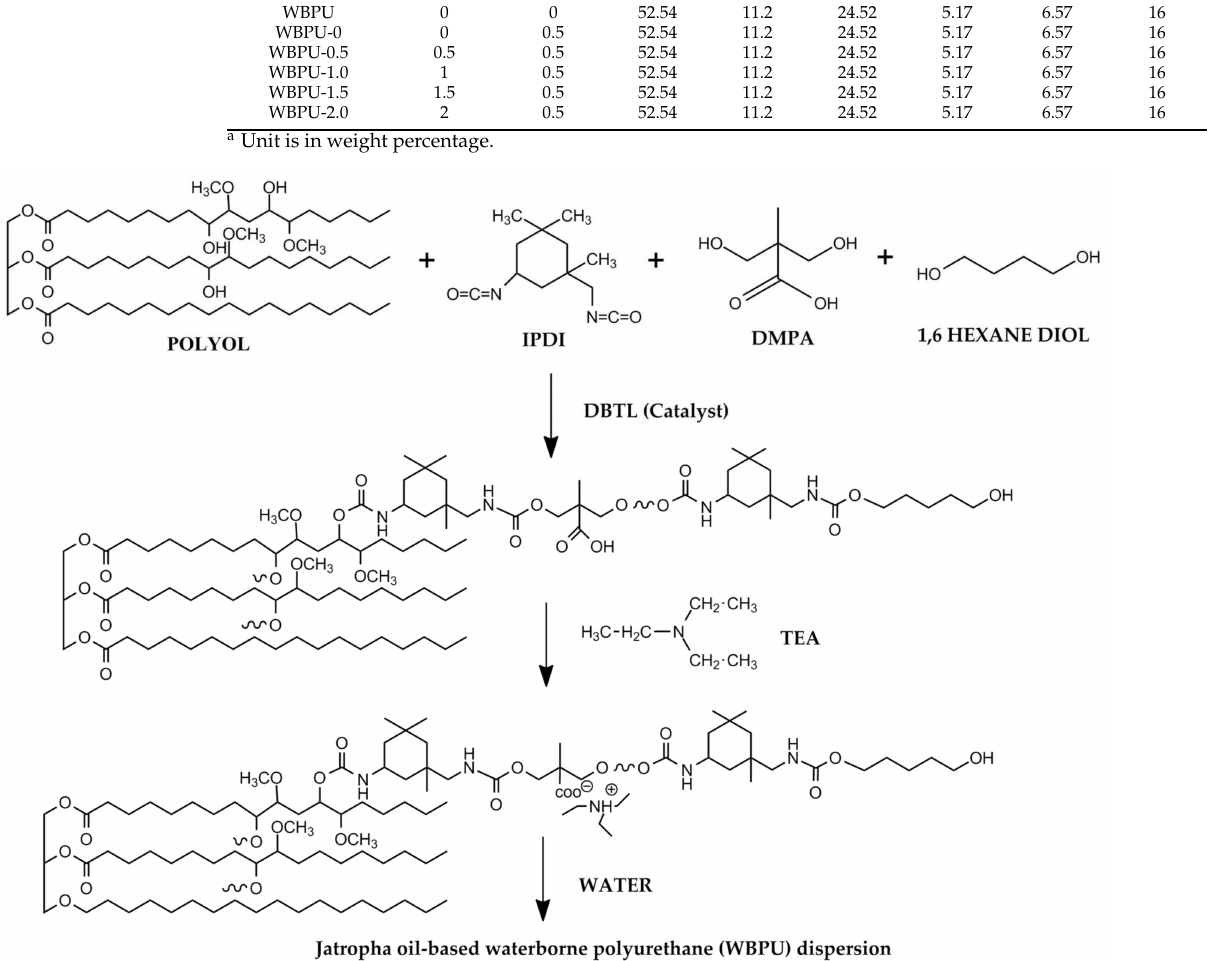
Figure 1. Reaction scheme of